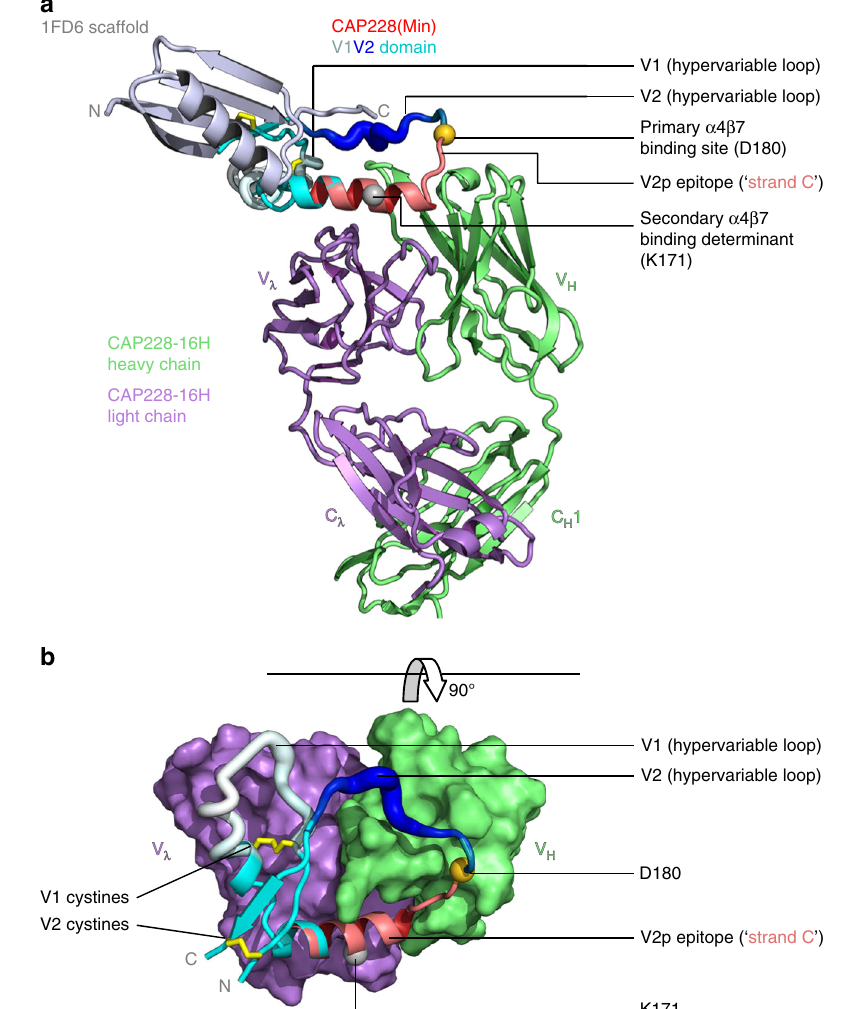
Fig. 4 Cocrystal structure of a scaffolded, helical V1V2 domain bound to CAP228-16H. a The 1FD6 scaffold (metallic blue), autologous CAP228(Min) V1V2 domain (multicolour) and CAP228-16H Fab heavy and light chains (green and purple, respectively) are shown in cartoon view. V1V2 regions are labelled as hypervariable loop 1 (residues 132 – 156, white), hypervariable loop 2 (residues 183 – 196, dark blue), and C strand (residues 167 – 179, red), with the remainder coloured cyan. Internal V1V2 disulphide bonds are shown as yellow sticks, while the primary α 4 β 7 binding site and potential secondary α 4 β 7 binding determinant are indicated with the gold and silver spheres, respectively. b The view has been rotated 90°, and the 1FD6 scaffold (which would point ‘ out of the page ’ ) has been omitted to clearly show the interaction. The CAP228-16H paratope is shown in surface view, with the V1V2 domain still in cartoon representation, coloured as